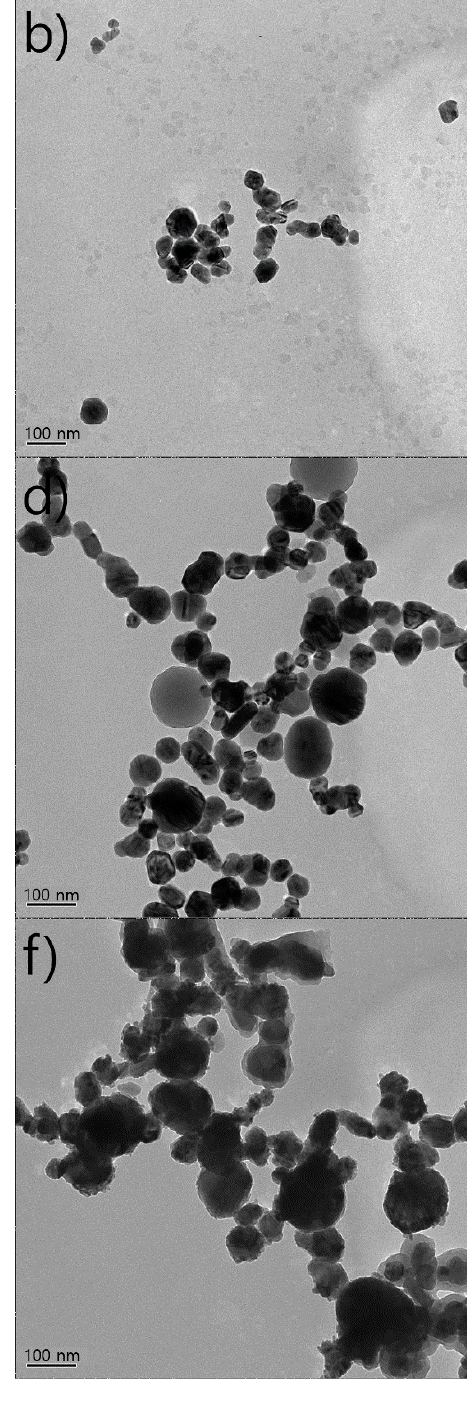
Figure 5. Transmission electron microscopy (TEM) images of Ag nanoparticles after being dried on a glass surface. ( a ) 164 fs, ( b ) 5 ps, ( c ) 4 ns, ( d ) 32 ns, ( e ) 64 ns, and ( f ) 100 ns pulse widths.